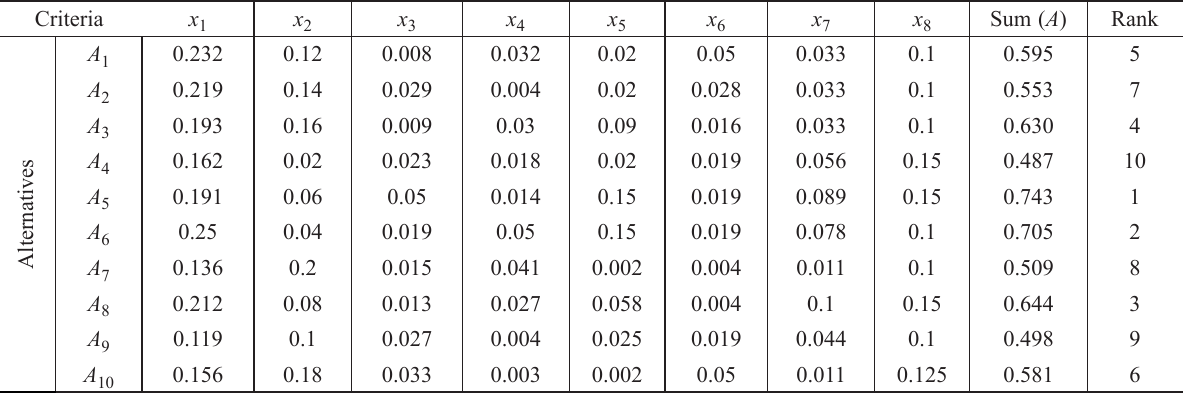
Table 2. The final decision matrix data Criteria